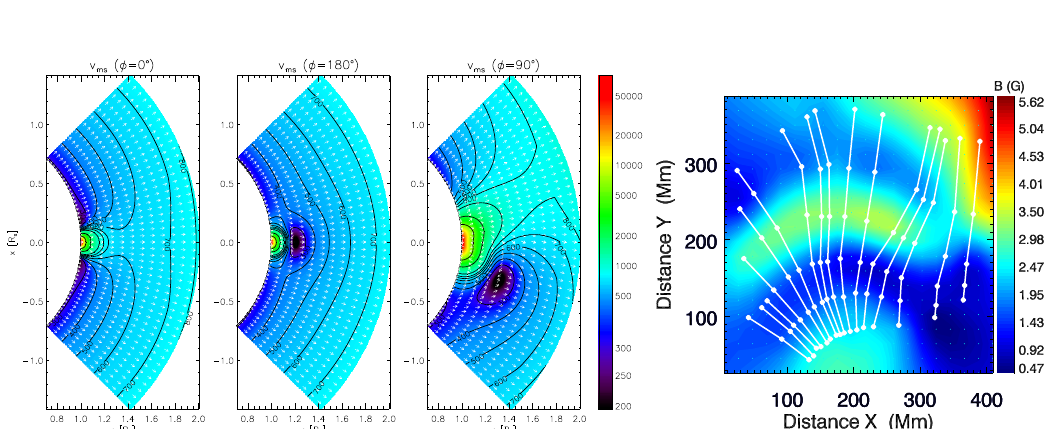
Figure 49: Results of coronal seismology. Left : distribution of the magnetosonic velocity based on a coronal density model and an analytic magnetic field model constrained by photospheric magnetograms and observed EIT wave speeds. The distribution is shown for three orientations of the dipole that models an active region. Colors indicate speeds, and arrows show the magnetic field directions. Right : the 2D distribution of the magnetic field strength in the quiet corona derived from observed TRACE wave speeds. Images reproduced with permission from [left] Warmuth and Mann (2005a), copyright by ESO, and [right] Ballai (2007), copyright by